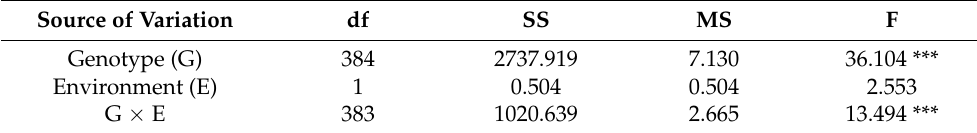
Figure 3. Lesion length distribution in the two populations (seasons). ( A ) Lesion length distribution of population 1. ( B ) Lesion length distribution of population 2. Table 1. Two-way analyses of variance of lesion lengths of 385 accessions planted in two seasons. Source of